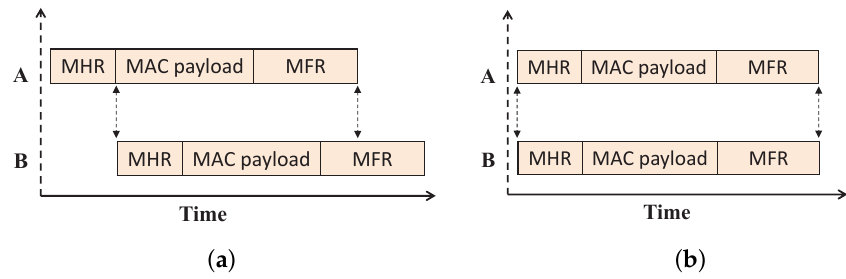
Figure 3. Overlapping of the data transmission frame due to the hidden terminal problem. ( a ) Partial overlapping of the data transmission frame; ( b ) full overlapping of the data transmission frame.